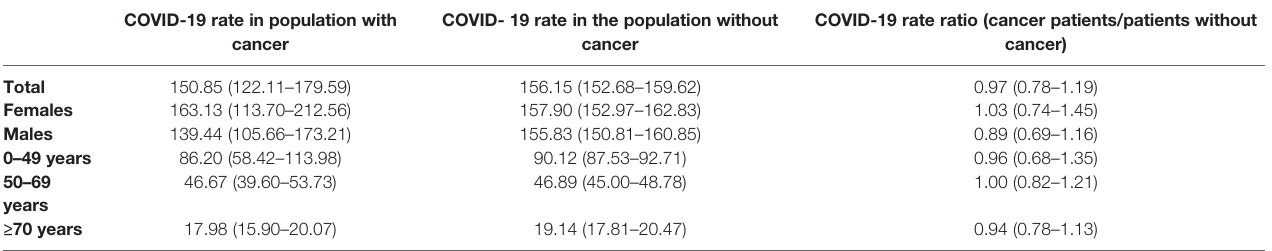
TABLE 1 | Age-standardized cumulative rates of COVID-19 among the cancer population versus the non-cancer population (per 100 000). COVID-19 rate in population with COVID- 19 rate in the population without COVID-19 rate ratio (cancer patients/patients without cancer cancer